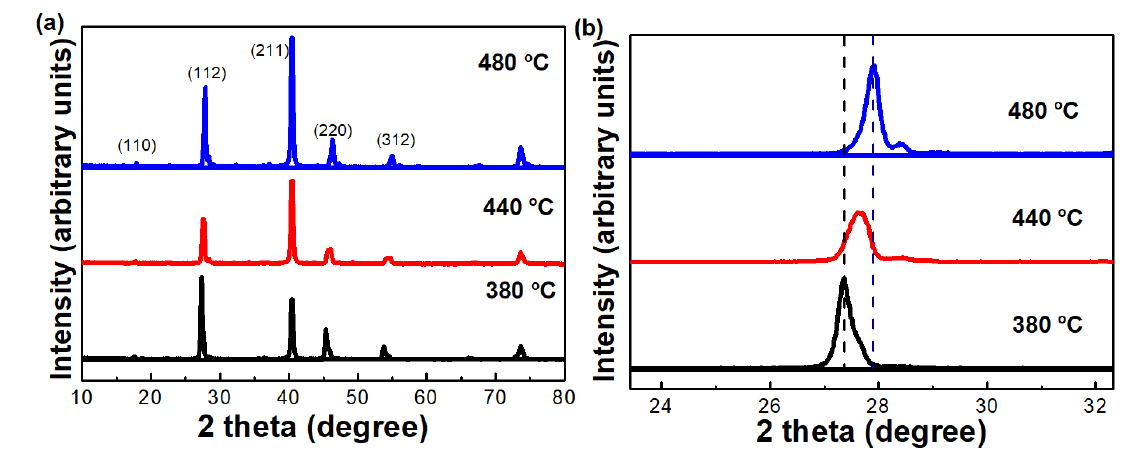
Figure 3. ( a ) XRD patterns of CZTSe films prepared at various temperatures ranging from 380 to 480 °C and ( b ) magnified view of the XRD (112) peak of CZTSe films.